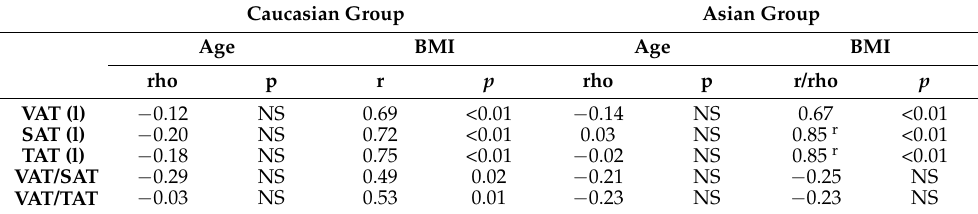
Figure 2. Side-by-side images showing a slice from images of age- and BMI-matched participants from the Asian cohort (A, BMI = 18.8 kg/m 2 ) and the Caucasian cohort (B, BMI = 18.1 kg/m 2 ) at the level of L3. Note the difference in VAT volume with higher VAT in participant A despite the similar BMI. VAT: green, SAT: blue. Abbreviations: BMI: Body Mass Index; SAT: Subcutaneous adipose tissue; VAT: Visceral adipose tissue. Table 3. Correlation results of relationships between adipose tissue measurements and age/BMI for each group. Caucasian Group Asian